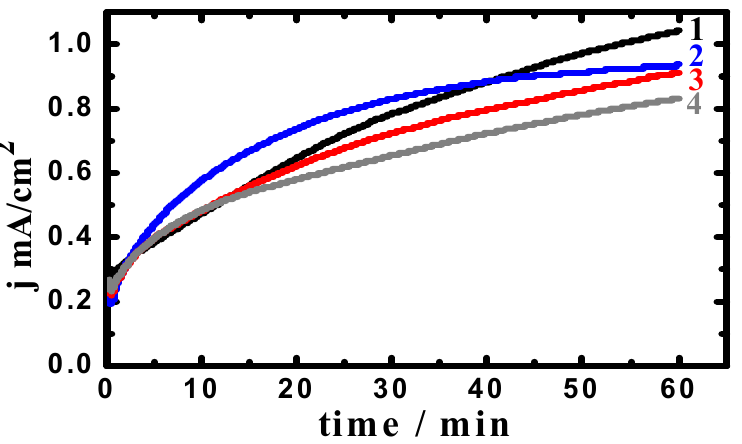
Figure 5. Current–time curves collected at − 475 mV (Ag/AgCl) for an iron rod in 3.5% NaCl solutions containing (1) 0.0 MAO, (2) 5 × 10 − 5 M MAO, (3) 1 × 10 − 4 M MAO, and (4) 5 × 10 − 5 M MAO after 48 h immersion.